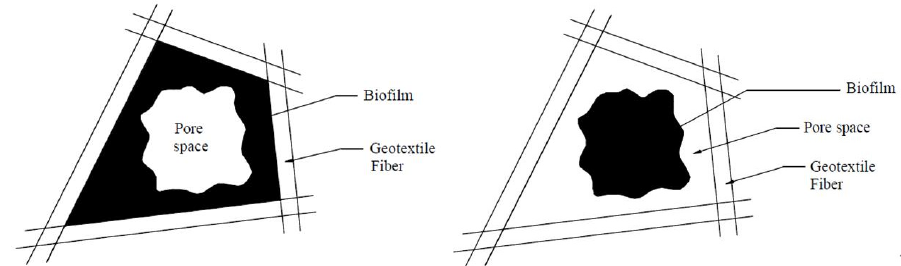
Figure 1. Two models for biomass accumulation in a fibrous geotextile structure (adapted after